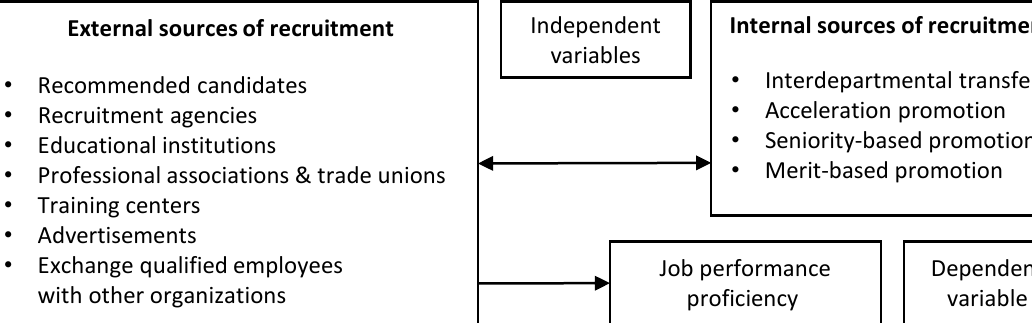
Figure 1. Study variables and components